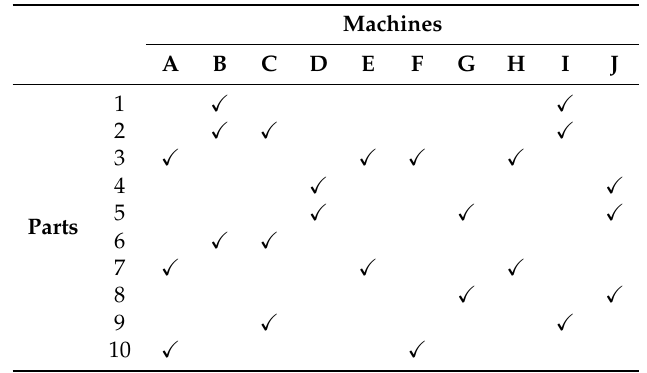
Table 1. Problem example. Machine-part matrix.